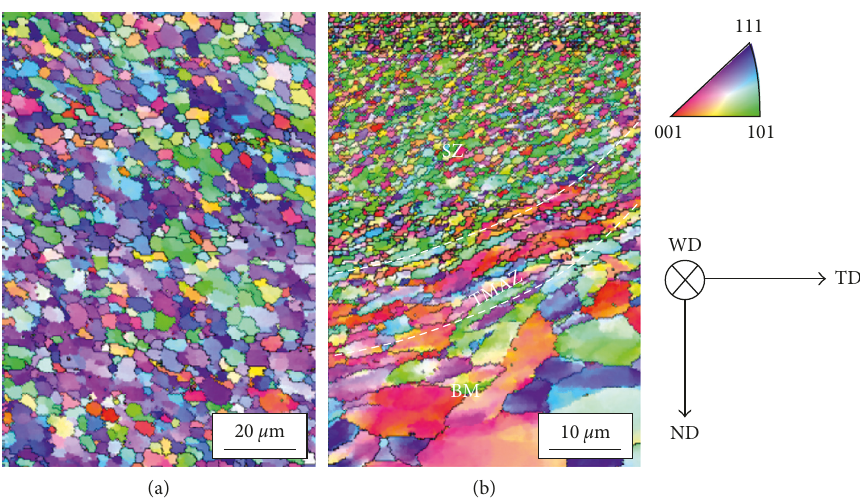
Figure 12: Inverse pole figure maps in (a) SZ and (b) TMAZ by the EBSD